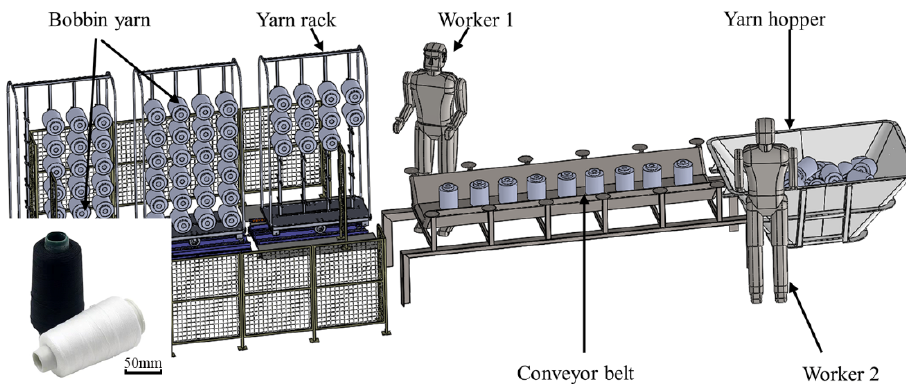
Figure 1. Manual yarn feeding process.